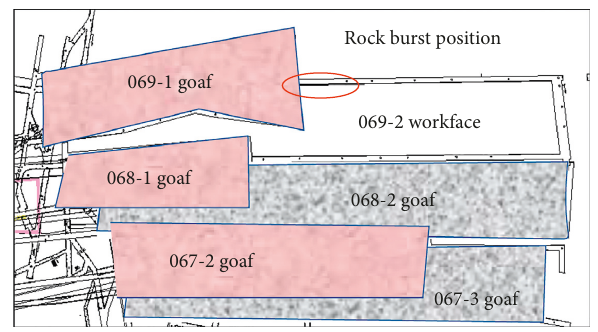
Figure 6: Location drawing of coal mining face and rockburst